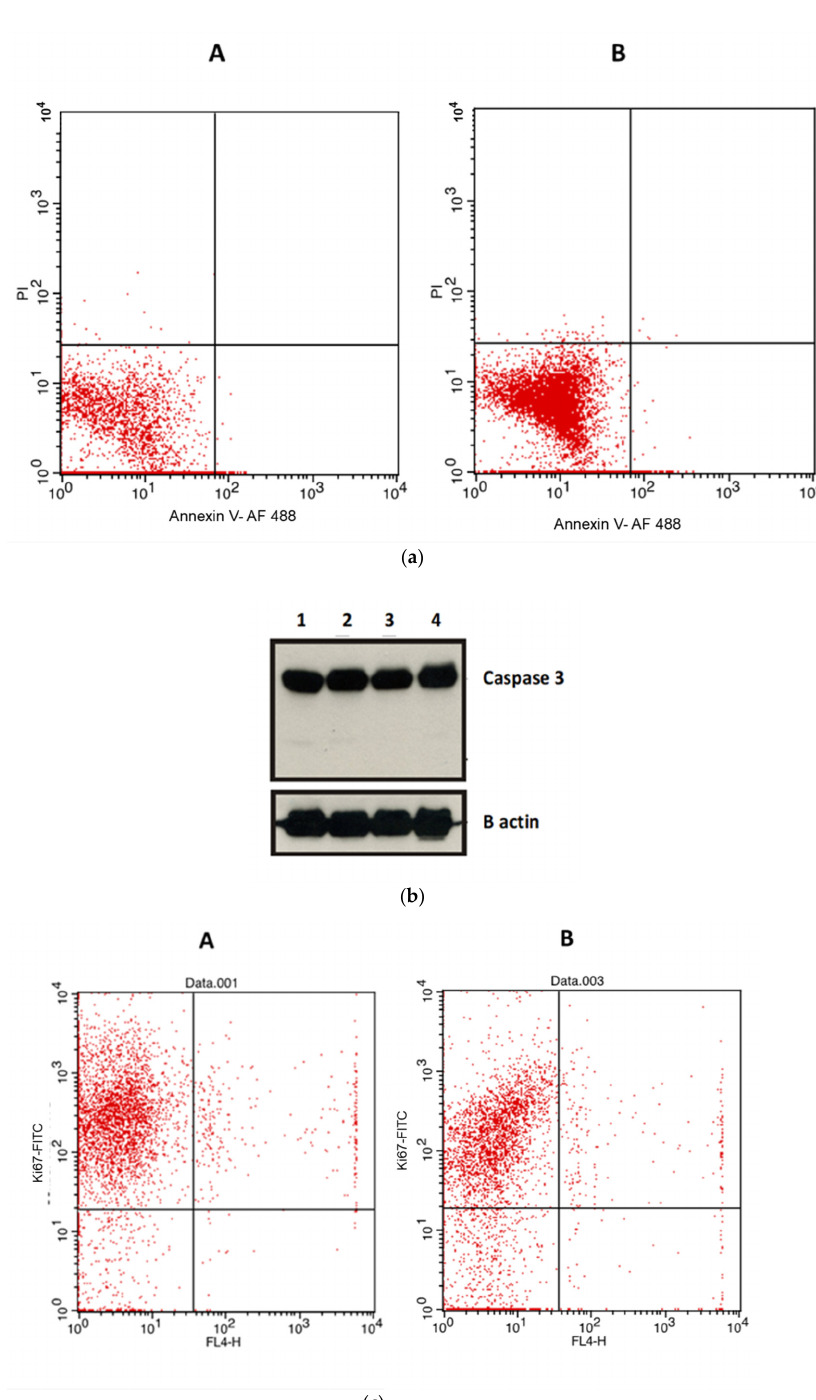
Figure 10. ( a ) Apoptosis analysis in A549 cells following treatment of cells with compound 7 at IC 50 concentration. Flowcy- tometry was conducted using Alexa Fluor 488 annexin V conjugate. The percentage gating in the lower left quadrant was ( A ) 97.8 in the control untreated cells and ( B ) 97.58% in compound 7 . ( b ) Western blot analysis showing cleaved caspase- 3 protein expression level. The upper panel shows (1) control, (2) compound 5 , (3) compound 6 , and (4) compound 7 at IC 50 concentration. The lower panel demonstrates B actin as loading control. ( c ) Proliferation analysis (Ki67) in A549 cells following treatment cells with compound 7 at IC 50 concentration. The analysis was done using flow cytometry and the Ki- 67 FITC antibody. ( A ) shows the flow cytometric analysis of the control, whereas ( B ) shows the flow cytometric analysis of compound 7